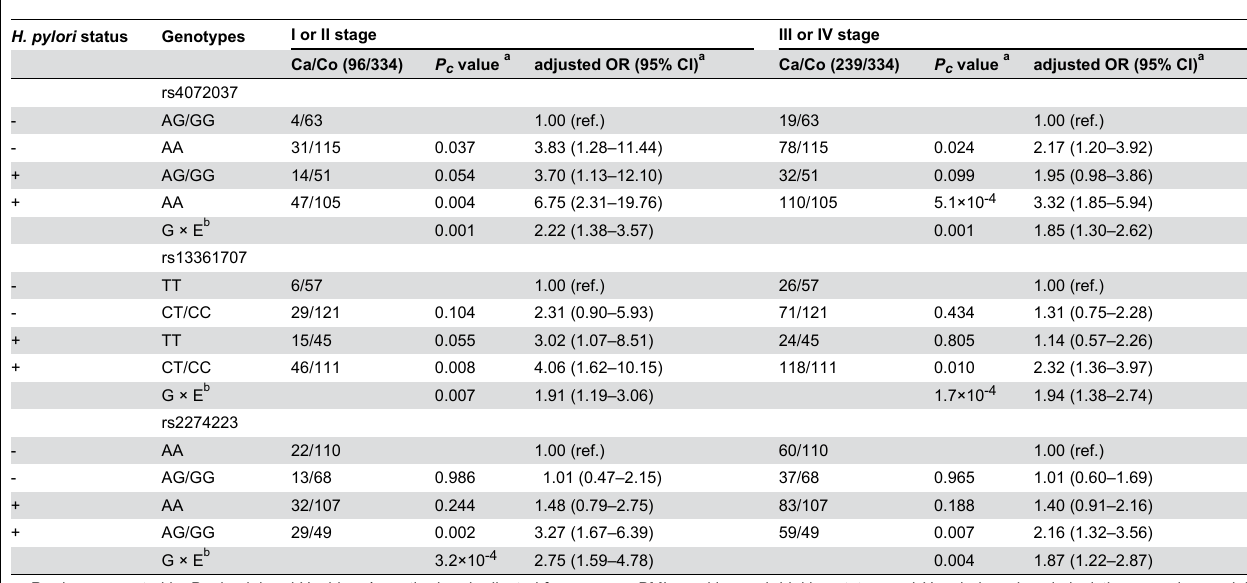
Table 5. Joint effects of H. pylori seropositivity and variants of three SNPs on GC risk stratified by TNM